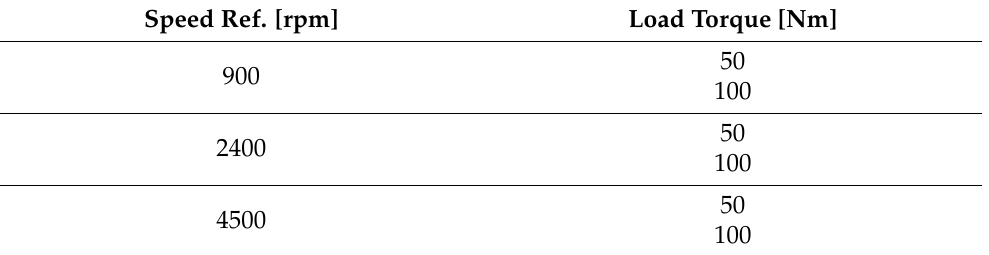
Table 1. Simulation scenarios for faulty data generation.